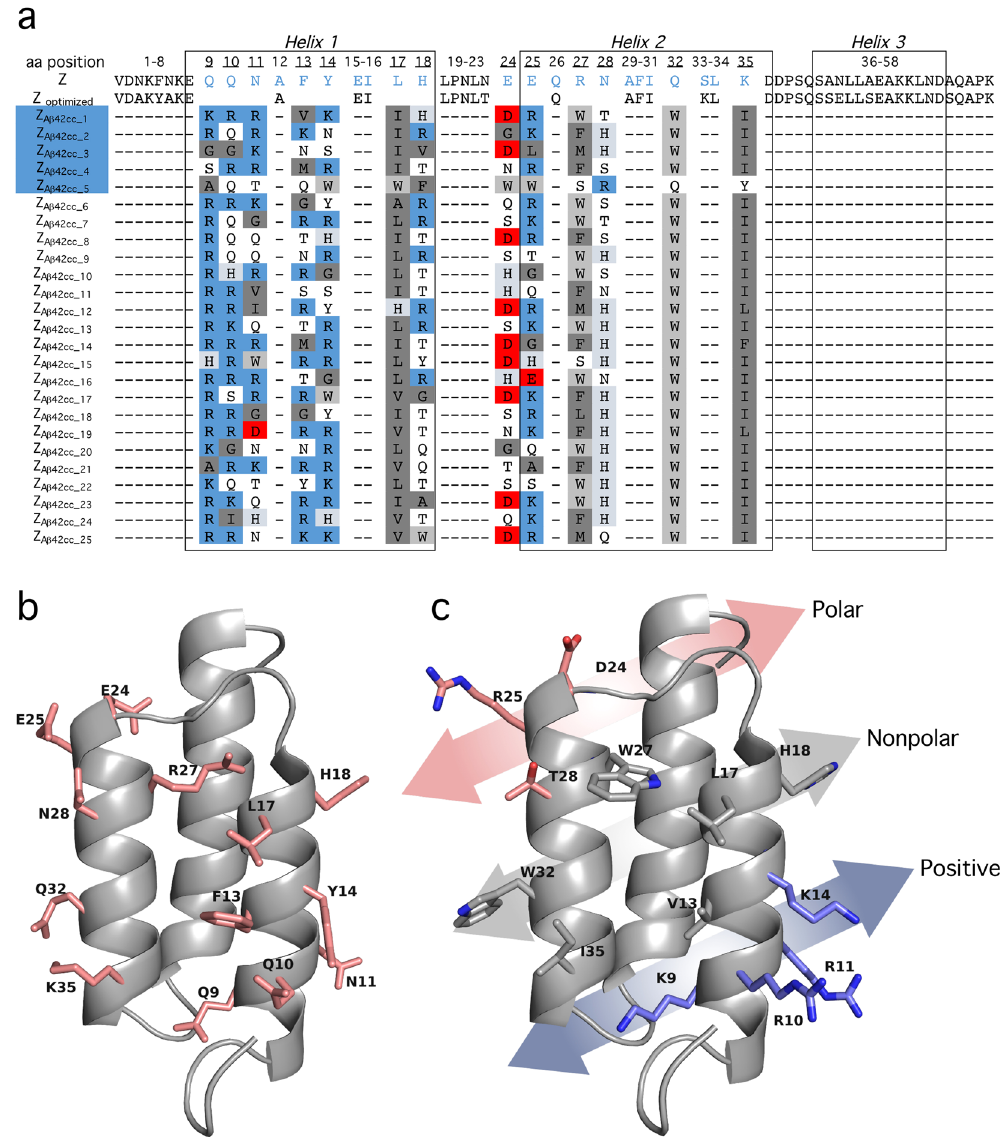
Figure 1. Sequence and cartoon representation of Affibody molecules selected as A β 42 cc protofibril binders. ( a ) Sequences of the top 25 selected Affibody molecules. The underlined amino acid positions are randomized in the phage display selection. The helical secondary structures are represented in boxes. The Affibody molecules chosen for further characterization are highlighted in blue. From 744 randomly picked clones, the sequence of Z A β 42cc_1 was identified eight times, Z A β 42cc_2 and Z A β 42cc_3 one time, Z A β 42cc_4 eight times and Z A β 42cc_5 three times. ( b ) The original Z-domain scaffold. Side chains of residues that are subjected to variation in the phage library are indicated. ( c ) Representation of side chains that are mutated in binder Z A β 42cc_1 . The chemical properties of the side chains of the selected binders group into three chemically distinct regions of the surface, which identifies a ‘positive-nonpolar-polar’ recognition surface